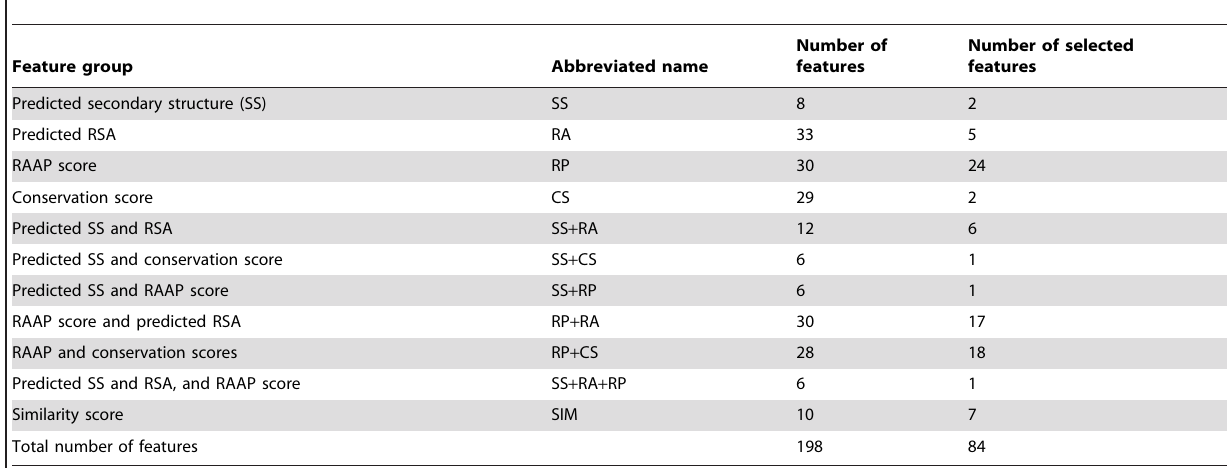
Table 1. Summary of the considered features and features selected and used in the proposed sequence-based predictor of B-cell epitopes.